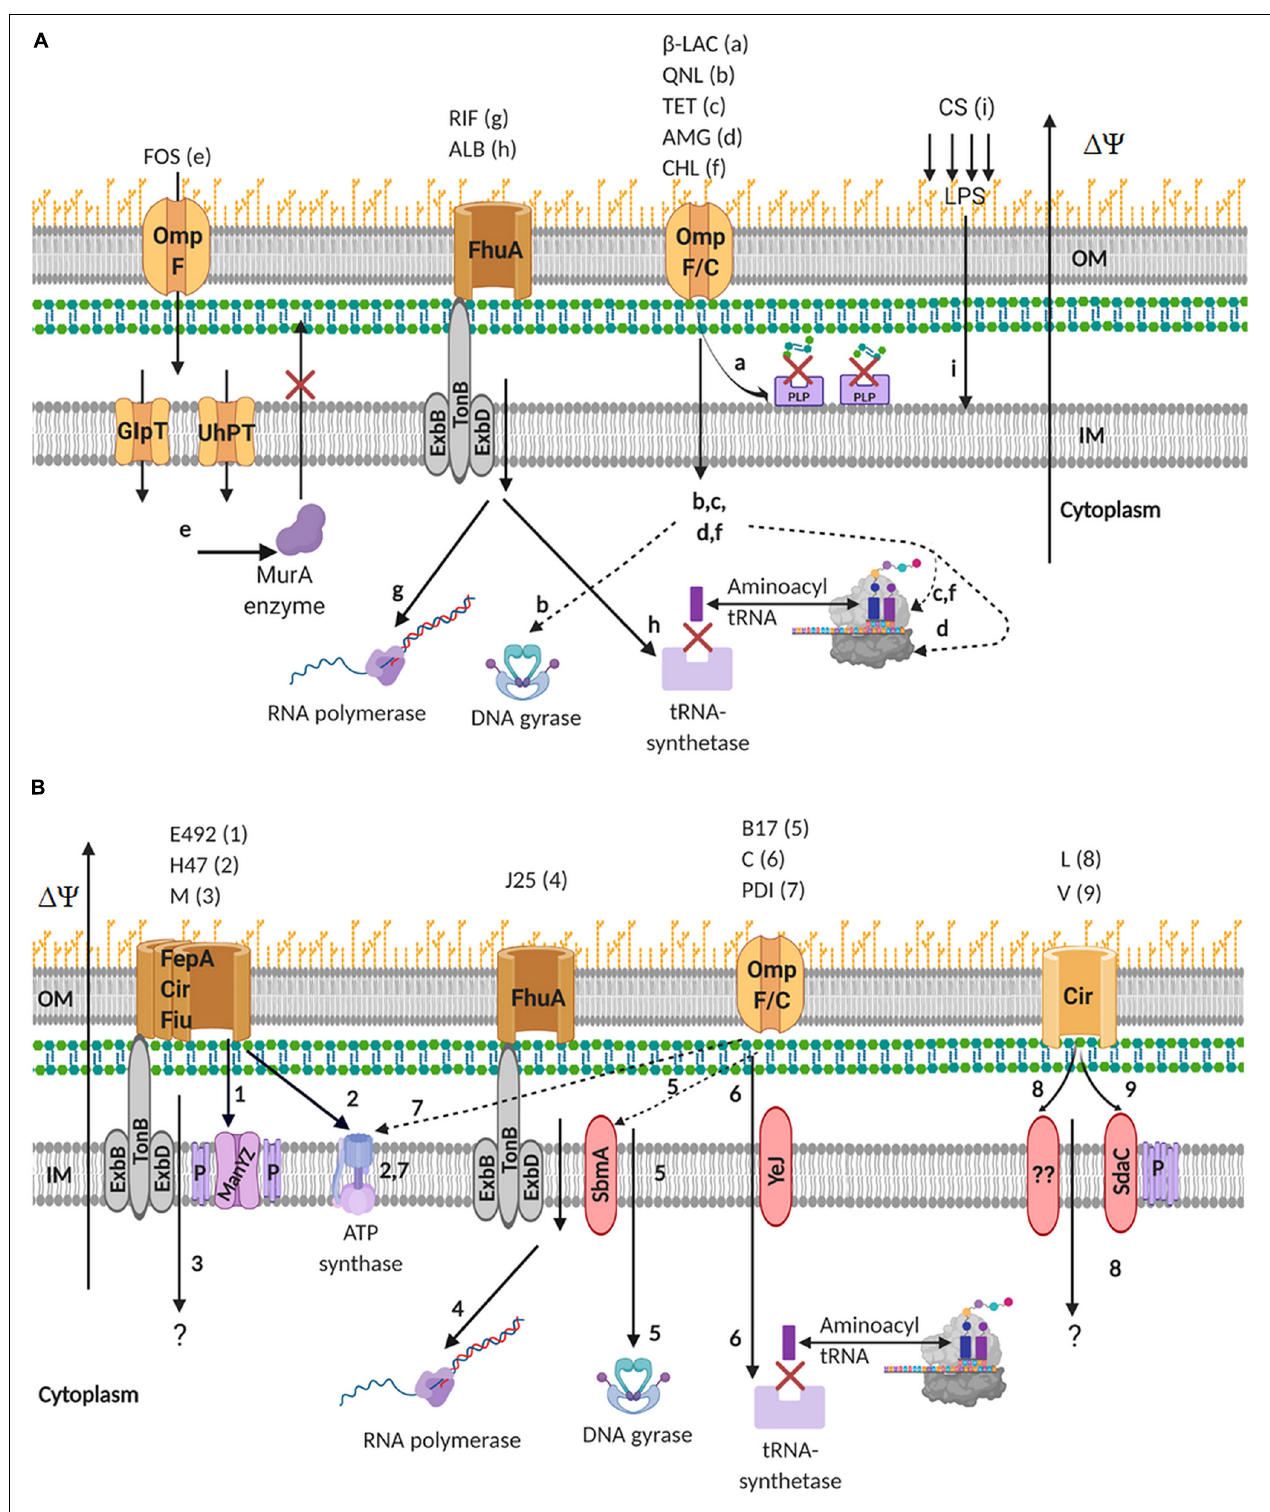
FIGURE 2 | Mechanisms of action of antibiotics (A) and microcins (B) against Gram-negative bacteria showing the membrane proteins involved in uptake into sensitive bacteria and the final targets. β -LAC, β -lactams; QNL, quinolones; TET, tetracycline; AMG, aminoglycosides; FOS, fosfomycin; CHL, chloramphenicol; CS, colistin; RIF, rifampicin; ALB, albomycin; P, pore; LPS, lipopolysaccharide. A letter and a number are assigned to each antibiotic and each microcin respectively, which are used in the scheme to identify the path they follow for their killing activity.